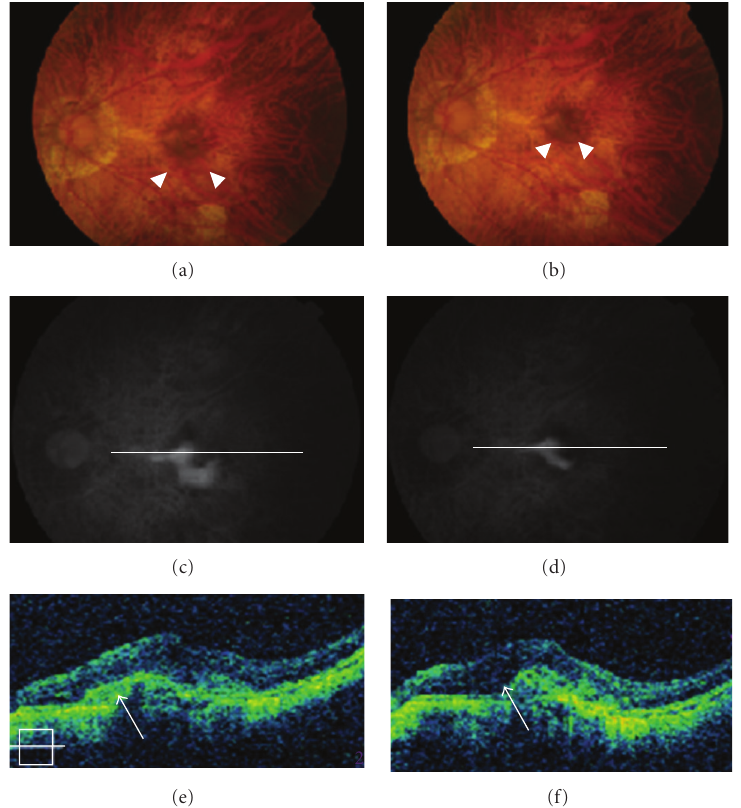
Figure 7: A 57-year-old female was referred for myopic CNV (a). Predominantly classic CNV was detected by FA (c), and a sub-retinal lesion with pigment epithelial detachment was found by OCT (e). With three months of oral alendronate administration, the lesion decreased remarkably in size (b), and the dye leakage was attenuated as detected by FA (d). OCT showed a decrease in the size of the subretinal lesion (arrows)